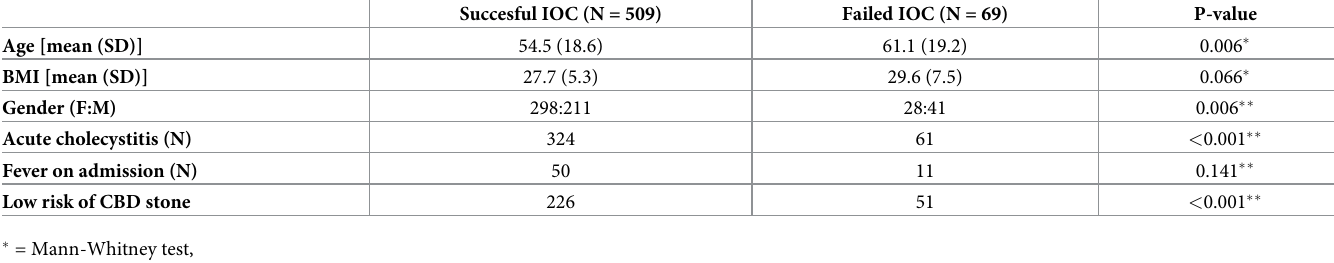
Table 4. Predictors of IOC failure (univariate analysis).